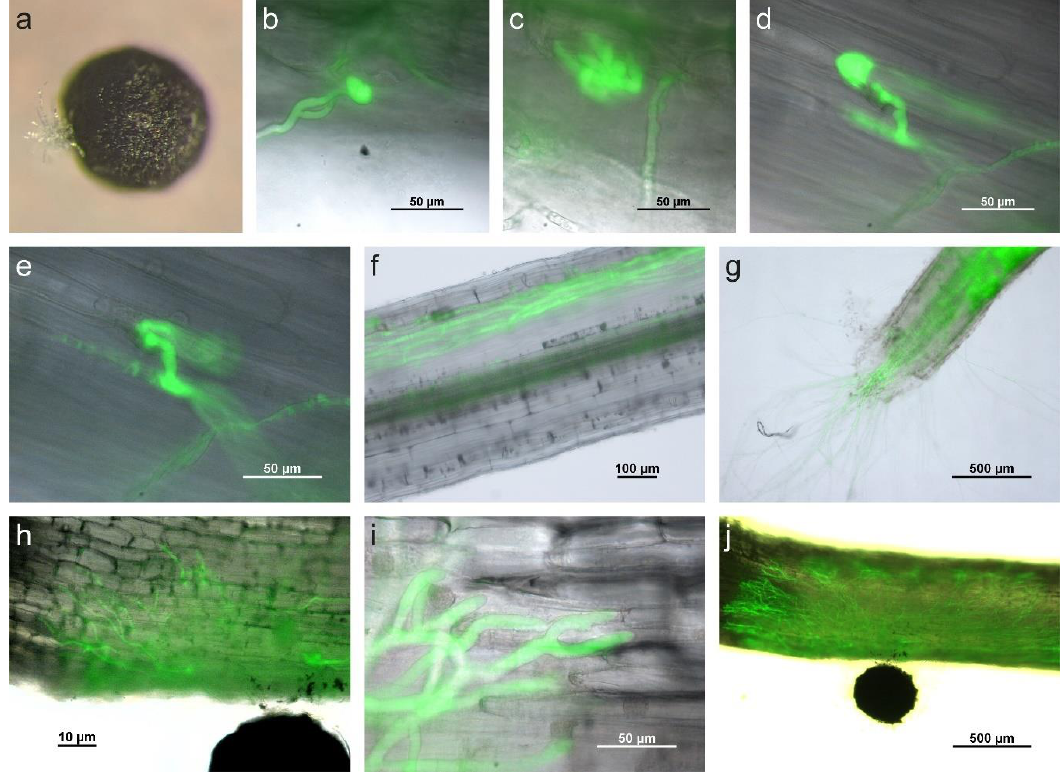
Figure 4. S. cepivorum on onion. ( a ) Binocular microscope image of a germinating sclerotium with outgrowth of hyphae. S. cepivorum attaching to host surface by forming ( b ) an appressorium-like structure and ( c ) an infection cushion observed by fluorescence microscopy. ( d , e ) Invasive hyphae growing inside the onion root 10 h after the formation of an appressorium-like structure. ( f ) Hyphae growing through cortical root tissue and ( g ) eventually growing through the root tip. ( h ) Spreading infection through an onion leaf, with ( i ) disintegrating onion tissue around leading hyphae. ( j ) Hyphae growing over the full width of an onion leaf 36 HPI.